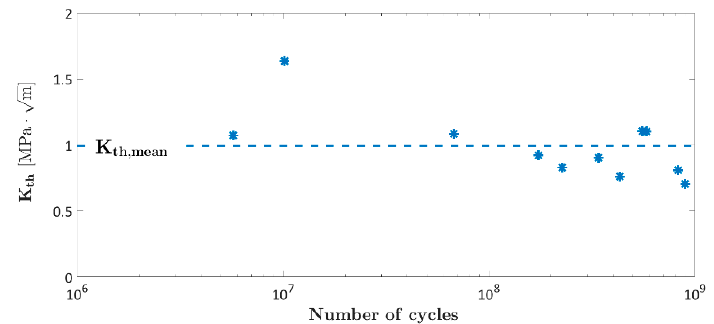
Figure 7. Stress intensity factor (SIF) threshold, with respect to N f .